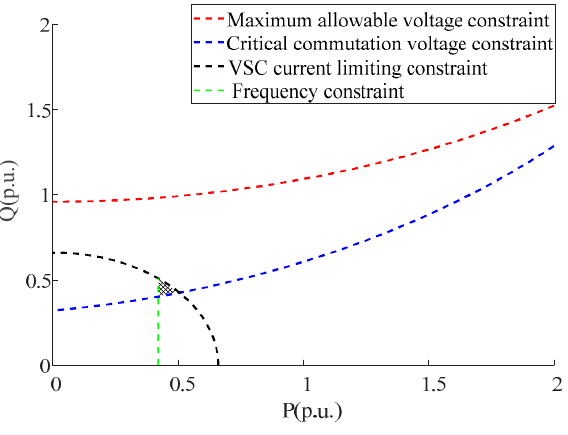
Figure 6. Controllable operation region of hybrid dual ‐ infeed HVDC system when U g = 0.8 p.u.